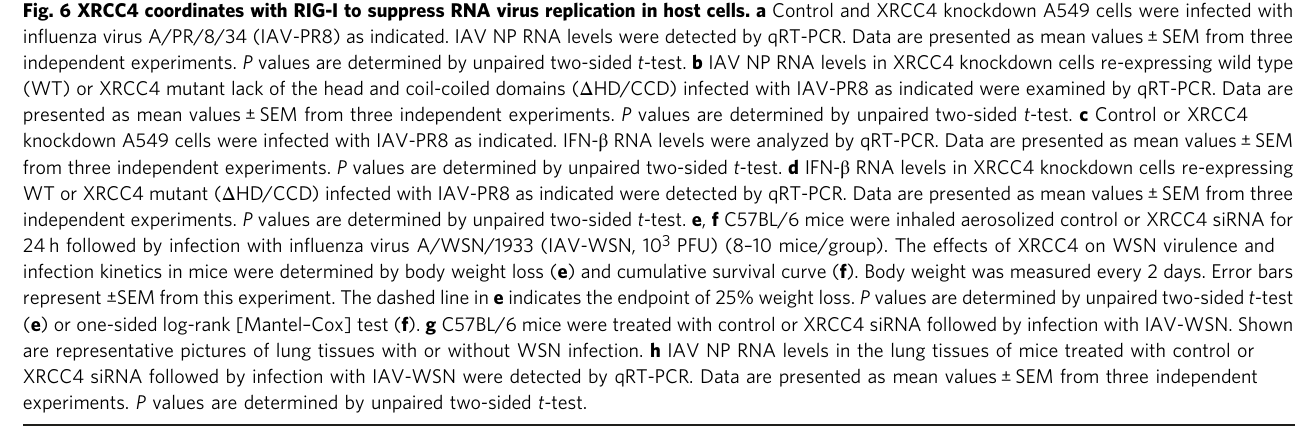
Fig. 6 XRCC4 coordinates with RIG-I to suppress RNA virus replication in host cells. a Control and XRCC4 knockdown A549 cells were infected with in fl uenza virus A/PR/8/34 (IAV-PR8) as indicated. IAV NP RNA levels were detected by qRT-PCR. Data are presented as mean values ± SEM from three independent experiments. P values are determined by unpaired two-sided t -test. b IAV NP RNA levels in XRCC4 knockdown cells re-expressing wild type (WT) or XRCC4 mutant lack of the head and coil-coiled domains ( Δ HD/CCD) infected with IAV-PR8 as indicated were examined by qRT-PCR. Data